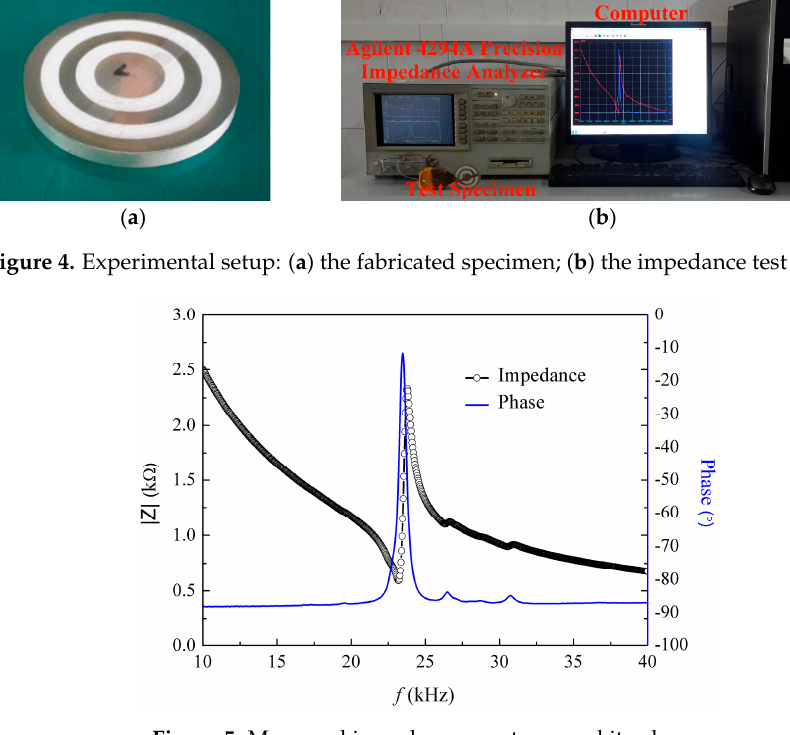
Figure 5. Measured impedance spectrum and its phase.